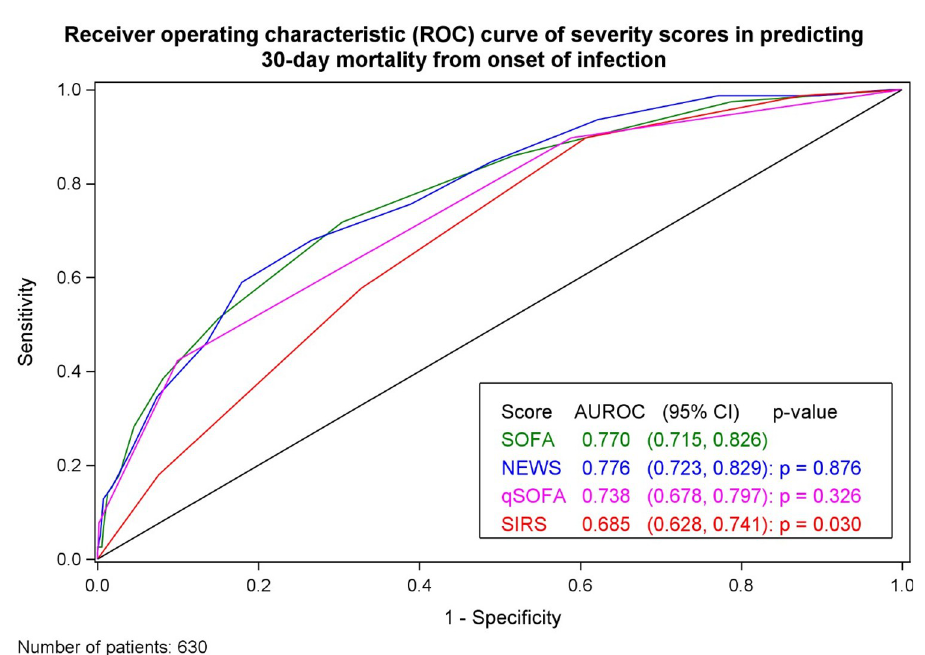
Fig 2. Receiver operating characteristic curves for 30-day mortality per severity score.